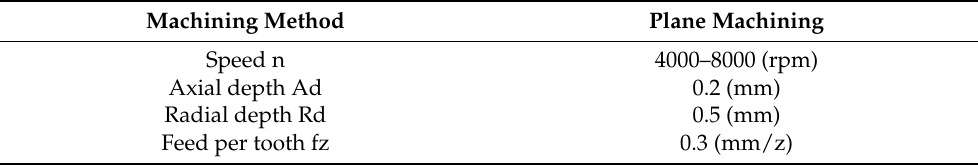
Table 3. Milling test machining